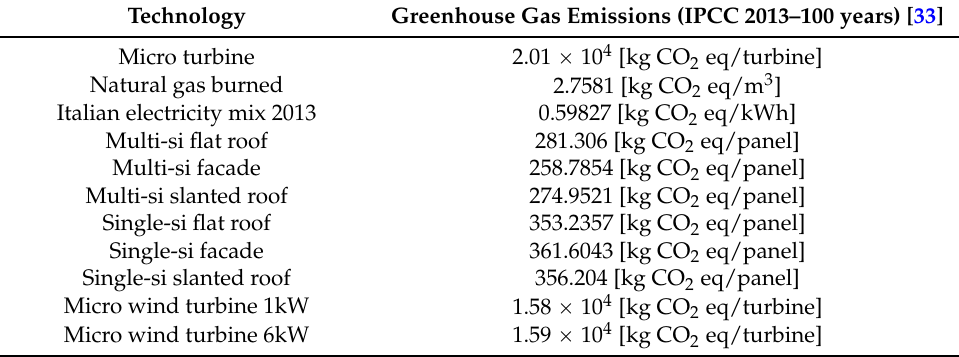
Table 1. Greenhouse Gas emission (GHG) of the technologies object of study. IPCC, Intergovernmental Panel on Climate